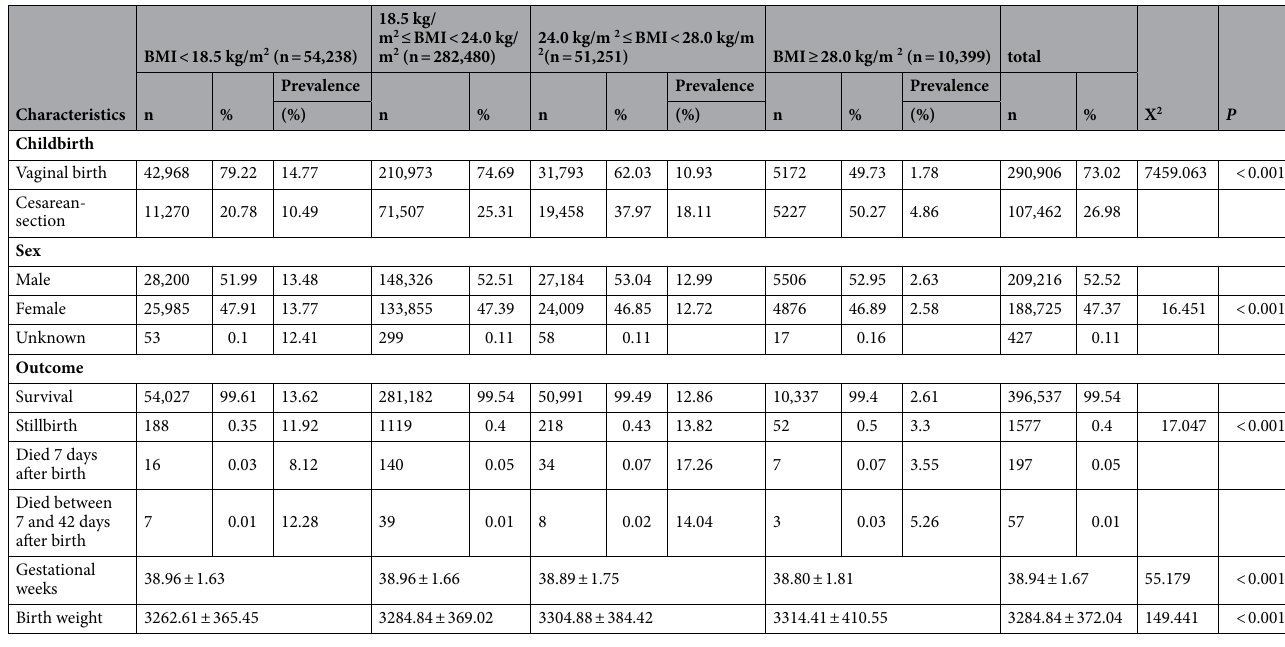
Table 2. Infant characteristics and the prevalence of pre-pregnancy